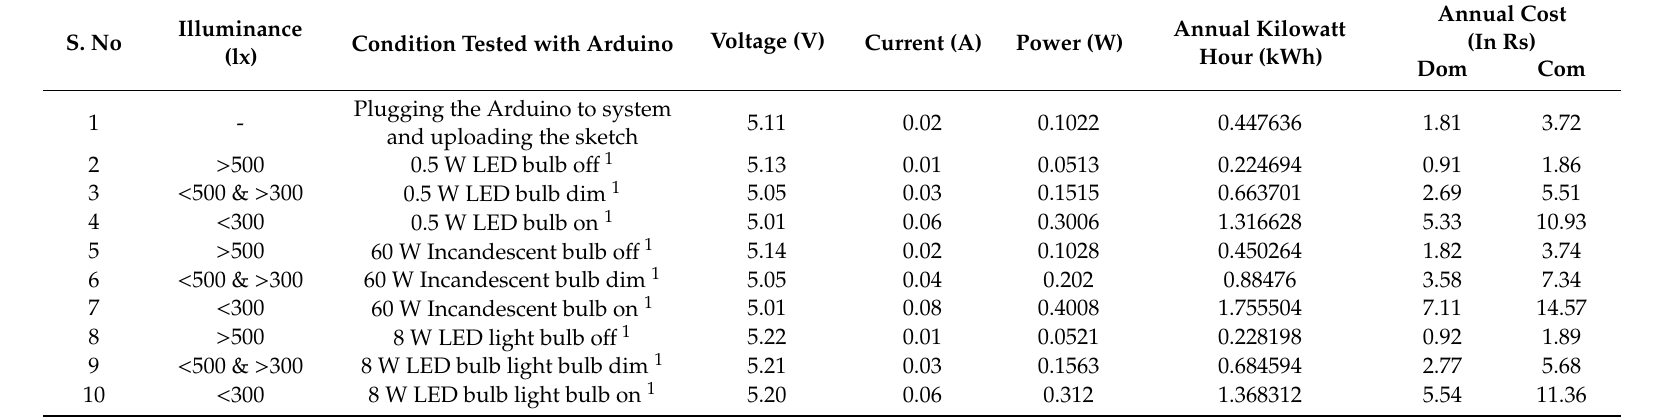
Table 6. Power analysis of PARSLAD.